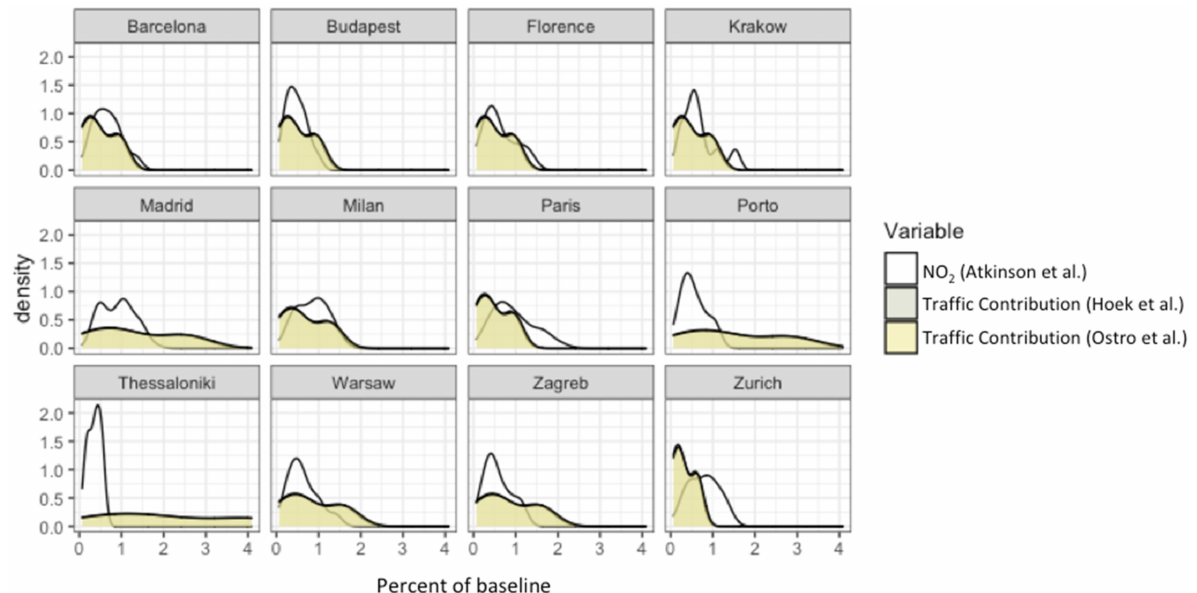
Figure 7. Probability density functions of percent of avoided mortality. Plots compared results based on both selected approaches, exposure to traffic-derived PM 2.5 concentrations and NO 2 concentra- tions, according to the different selected risk ratios (as reported by Atkinson et al. [69], Hoek et al., [68] and Ostro et al. [45]).